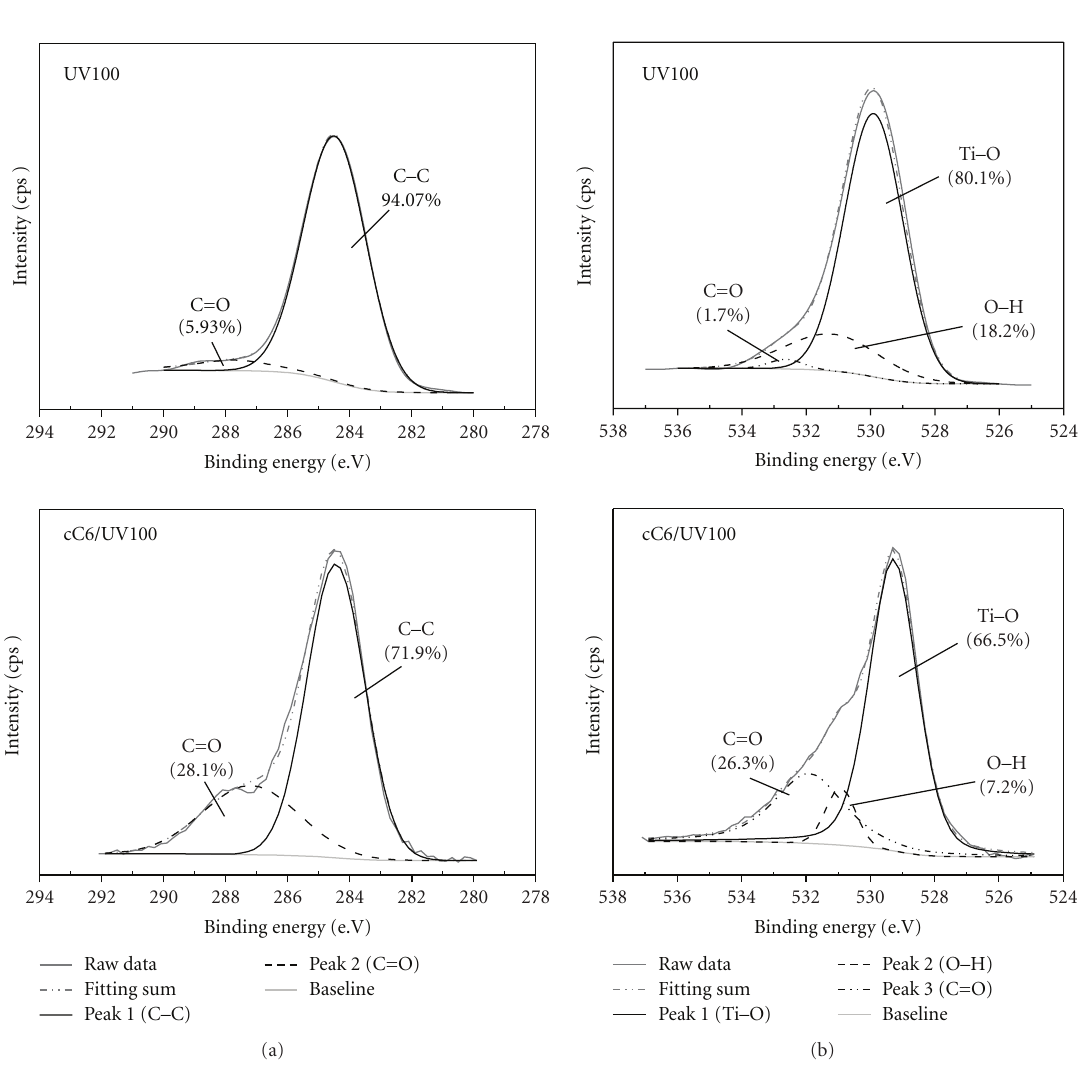
Figure 9: Deconvolution of C 1s (a) and O 1s (b) XPS spectra for UV100 and